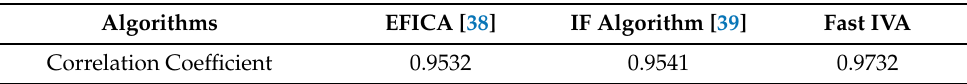
Table 2. Correlation coefficient of each separated signal with the source signal.